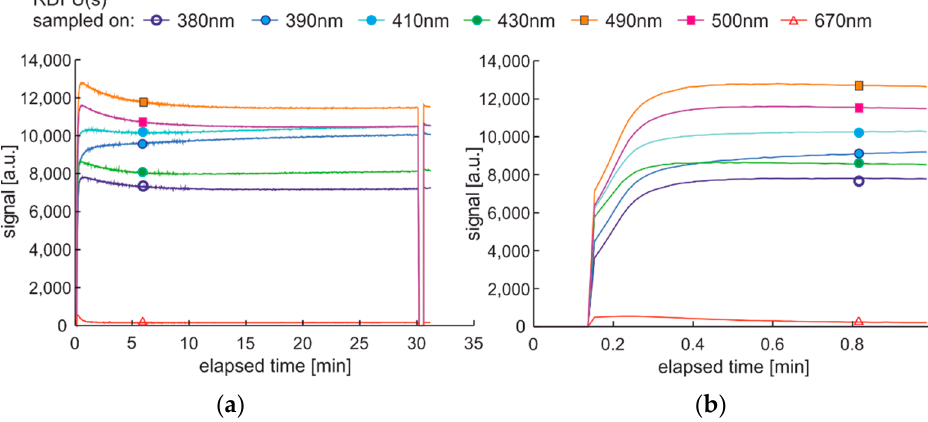
Figure 15. Time series of fluorescence data of regular diesel fuel in unmodified and summer type RDFU(s) examined in cycle DCE:UVonToff: ( a ) full-time series; ( b ) zoom of the initial stage. The degradation with thermal radiation is made in the cycle named